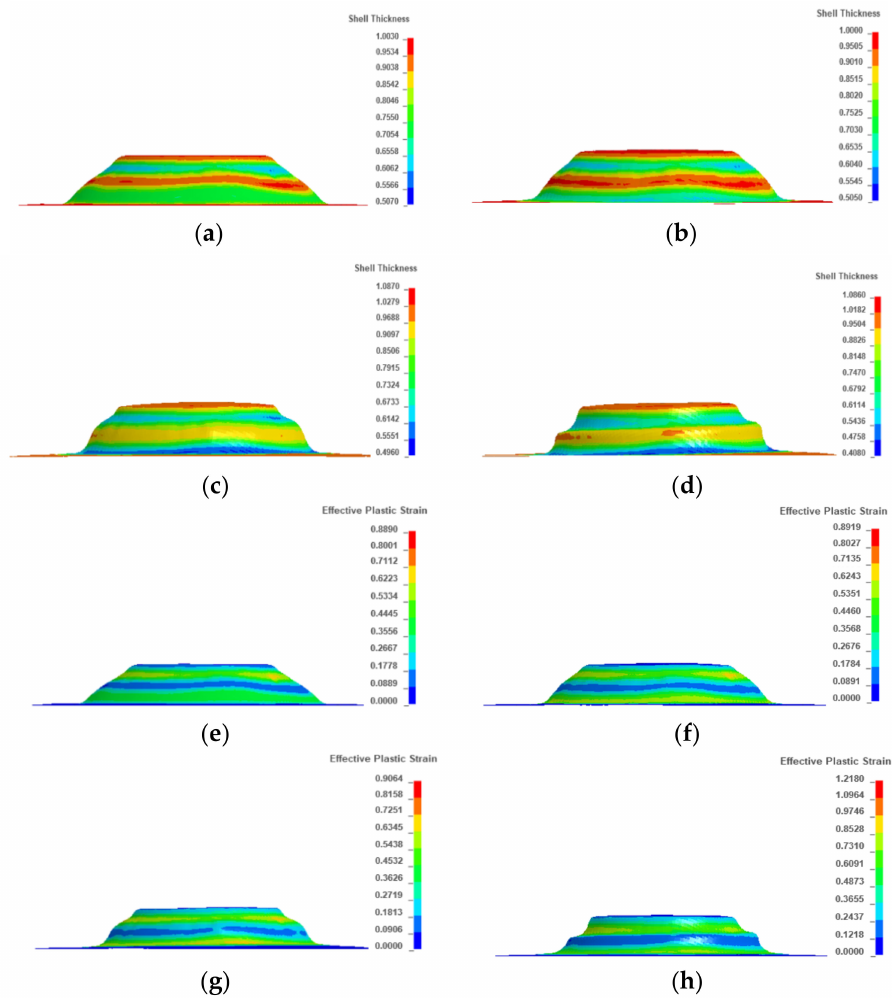
Figure 11. Contours of the thickness and e ff ective plastic strain: ( a ) thickness contour of the first pass, ( b ) thickness contour of the second pass, ( c ) thickness contour of the third pass, ( d ) thickness contour of the fourth pass, ( e ) strain contour of the first pass, ( f ) strain contour of the second pass, ( g ) strain contour of the third pass, and ( h ) strain contour of the fourth pass.